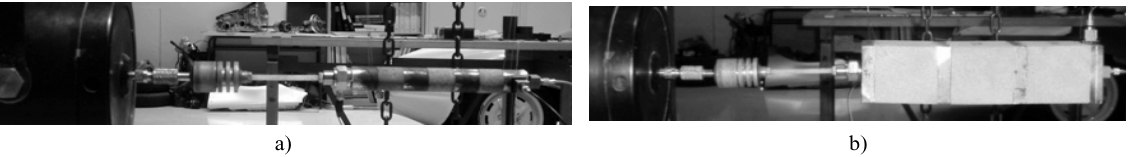
a) b) Fig. 7. Experimental setup for a 3.5 cells heterogeneous bar: a) steel-commercial cork agglomerate specimen; b) steel-cork agglomerate (ref. 8123 [27])